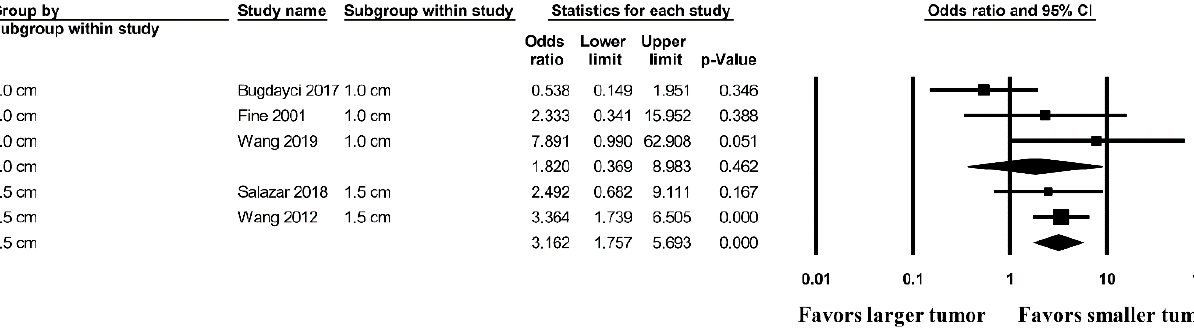
Table 4. The estimated complication rates after vacuum-assisted and open excision.